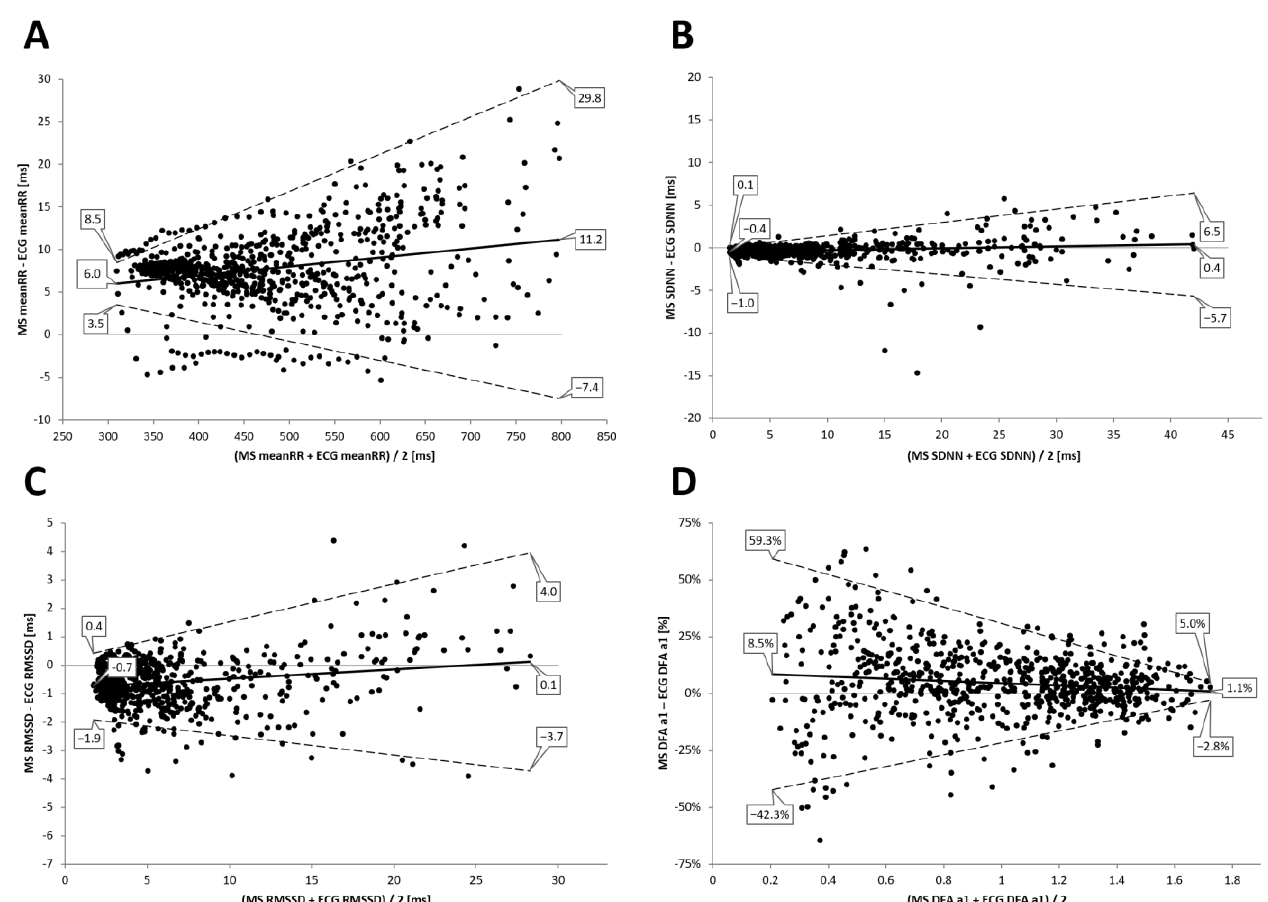
Figure 6. Bland–Altman analysis for the comparison of the 12 channel ECG (ECG) and the Movesense Medical sensor (MS) during the incremental exercise test for meanRR ( A ), SDNN ( B ), RMSSD, ( C ) and DFA a1 ( D ). Center solid line in each plot represents the mean bias (difference) between each paired value as absolute time (ms) or relative differential (difference/mean × 100) in the case of DFA a1. The top and bottom dashed lines are 1.96 standard deviations from the mean difference. Table 2. Mean, standard deviation (SD), Median, Minimum, Maximum, adjusted median difference (AMD) for the comparison of the 12 channel ECG (ECG) and the Movesense Medical sensor (MS) according to Hodges Lehmann method ( p -value estimated by Wilcoxon paired testing), Pearson’s r and Standard Estimate of Error (SEE) from paired data for meanRR, SDNN, RMSSD, and DFA a1 during the incremental exercise.